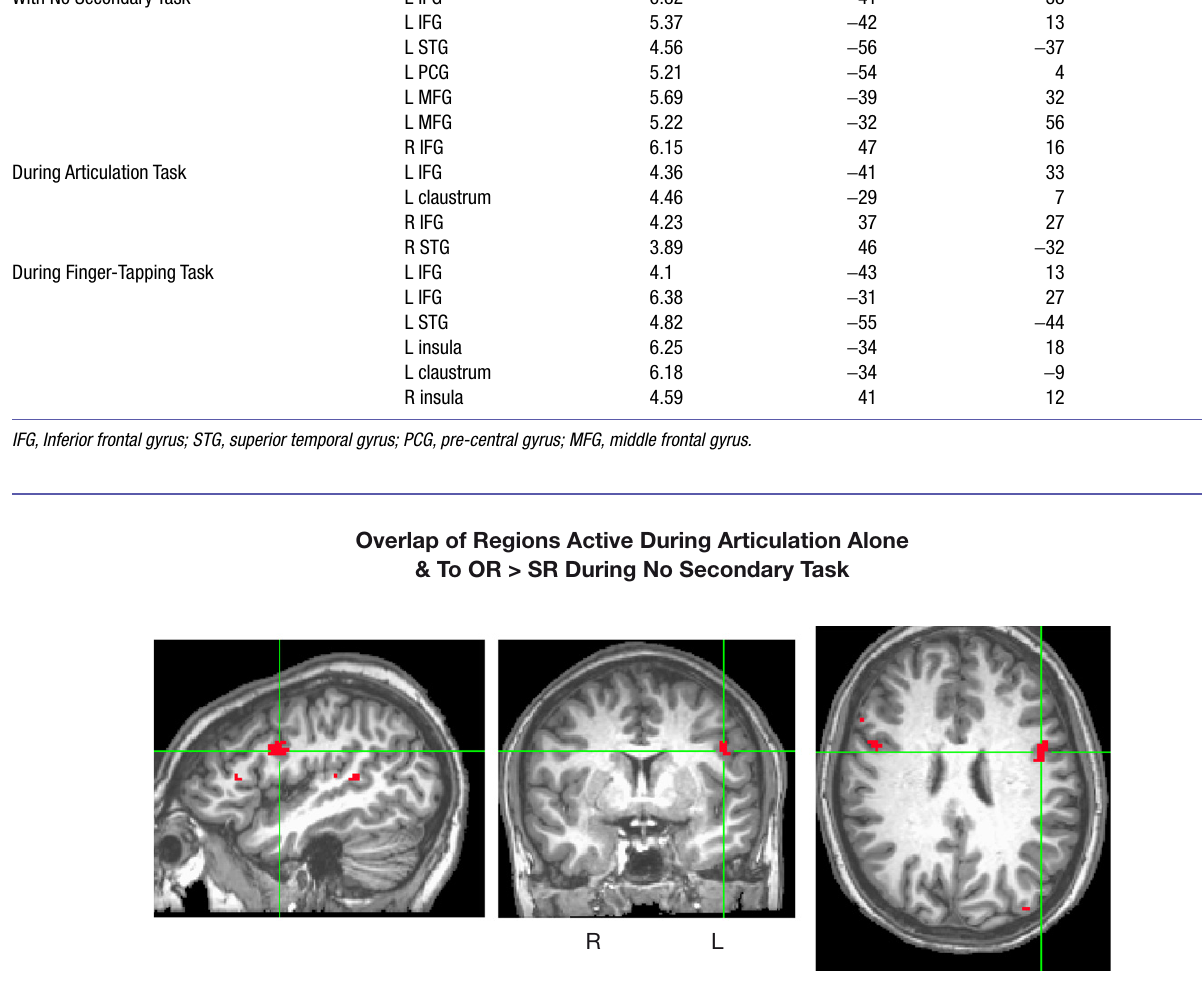
Figure 6 | Conjunction of regions active during articulation alone ( p < 0.005) and regions more active during object-relative than subject-relative sentences during no secondary task ( p < 0.005). The crosshairs converge on the largest voxel meeting these criteria (left pars opercularis, − 42 12 25).